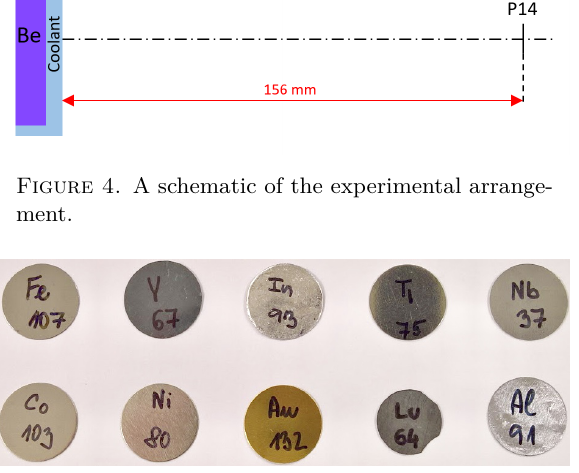
Figure 5. The set of activation